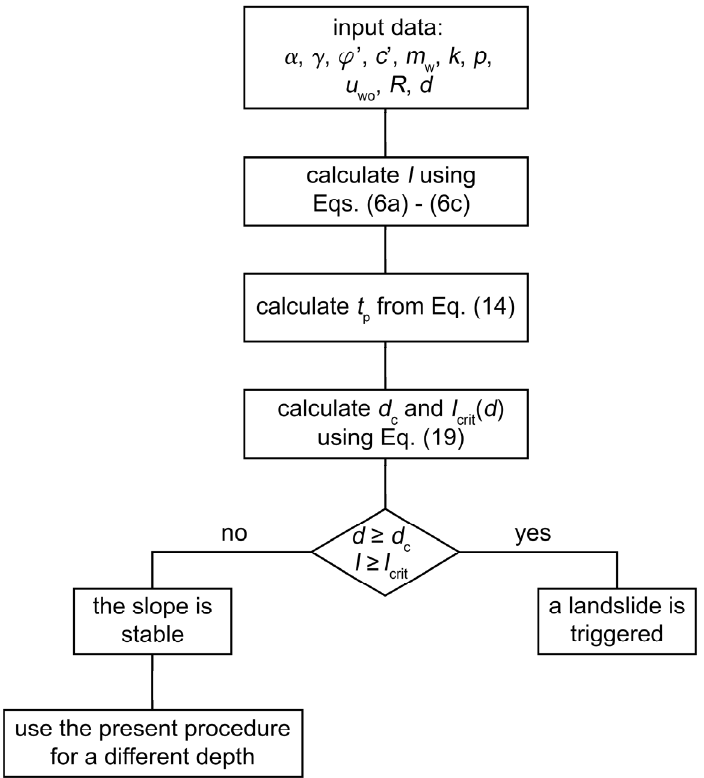
Figure 5. Flow chart illustrating the use of the proposed method. The critical duration, c d , is cal- culated using Equation (19) in which pI = crit is